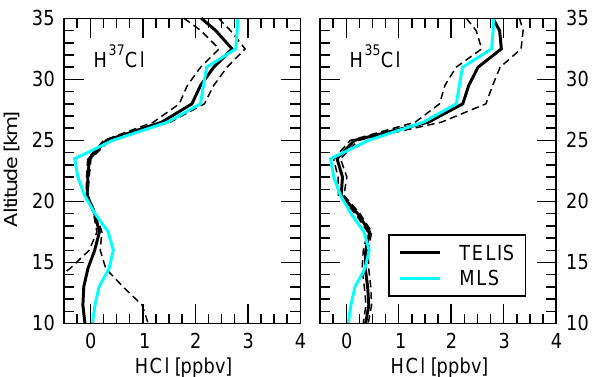
Fig. 3. The retrieved HCl vertical profiles in ppbv from the TELIS balloon flight on 24 January 2010 in chlorine activated Arctic air. The minimum in the profiles around 23km is due to the conversion of inactive reservoir chlorine into active chlorine. The left panels pertain to H 37 Cl and the right to H 35 Cl. The profiles are shown in black for TELIS and in blue for the MLS instrument. The dashed lines indicate the overall accuracy in the TELIS